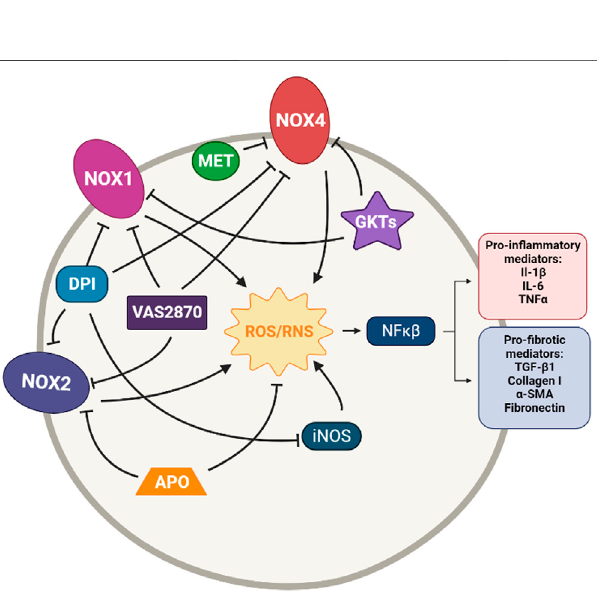
FIGURE1| Simpli fi eddiagramoftheprincipalmolecularmechanismsof the NOX inhibitors Diphenyleneiodonium (DPI), VAS2870, GKT137831 and GKT136901 (GKTs), Apocynin (APO) and Metformin (MET). α SMA: alpha smooth muscle actin; IL-1 β : interleuquina 1beta; IL-6: interleuquina 6; iNOS: inducible nitrogen oxide synthase; NF κβ : nuclear factor kappa beta; NOX1,2,4: NADPH oxidases; ROS/RNS: reactive oxygen species/reactive nitrogen species; TGF- β 1: transforming growth factor beta 1; TNF α : tumoral necrosis factor alpha Created with